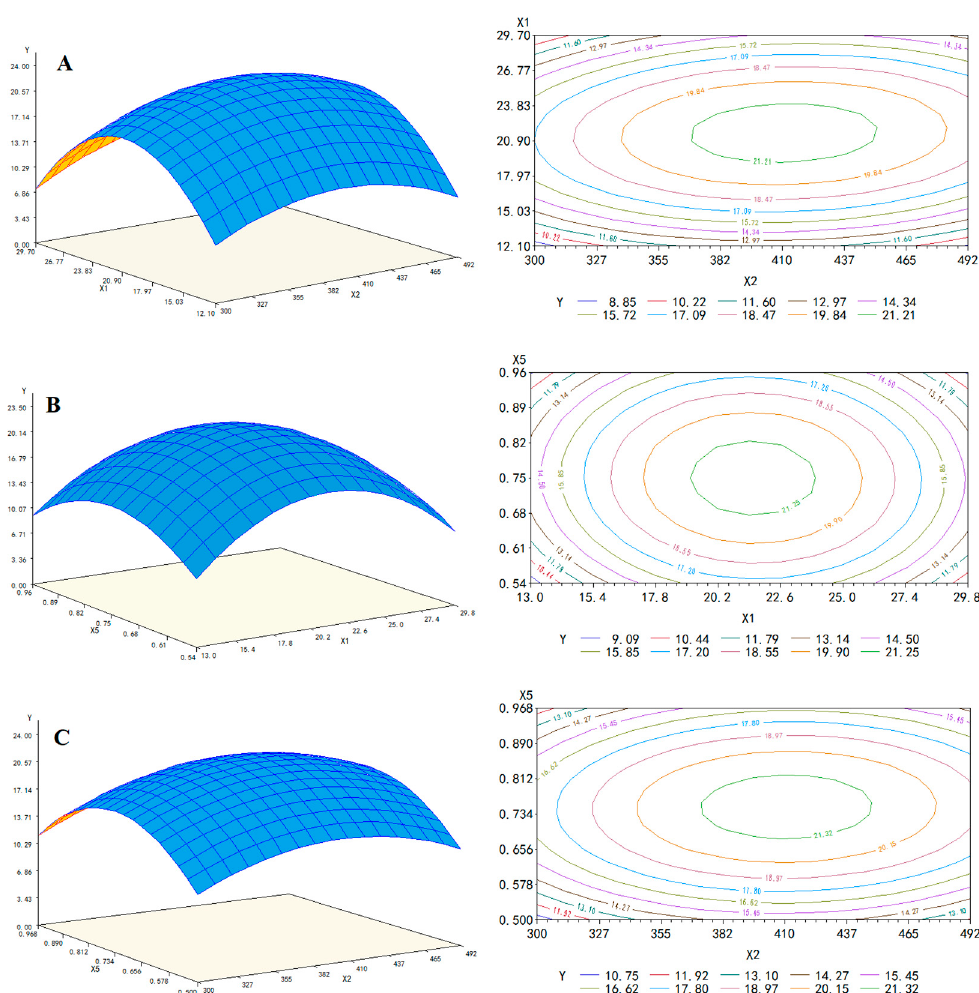
Figure 1. Response surface and contour map of total content of targets. ( A ) Ultrasonic power (X 2 ) and liquid-solid ratio (X 1 ) and, ( B ) liquid-solid ratio (X 1 ) and methanol volume fraction (X 5 ), and ( C ) ultrasonic power (X 2 ) and methanol volume fraction (X 5 ).